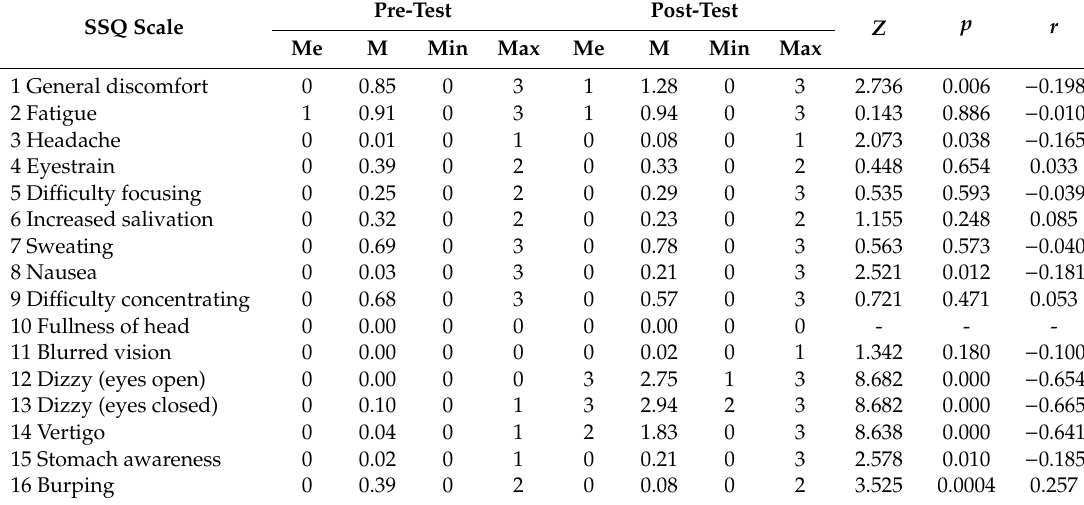
Table 3. Descriptive statistics of particular symptoms of the Simulator Sickness Questionnaire (SSQ) for pre- and post-test (Wilcoxon signed-rank